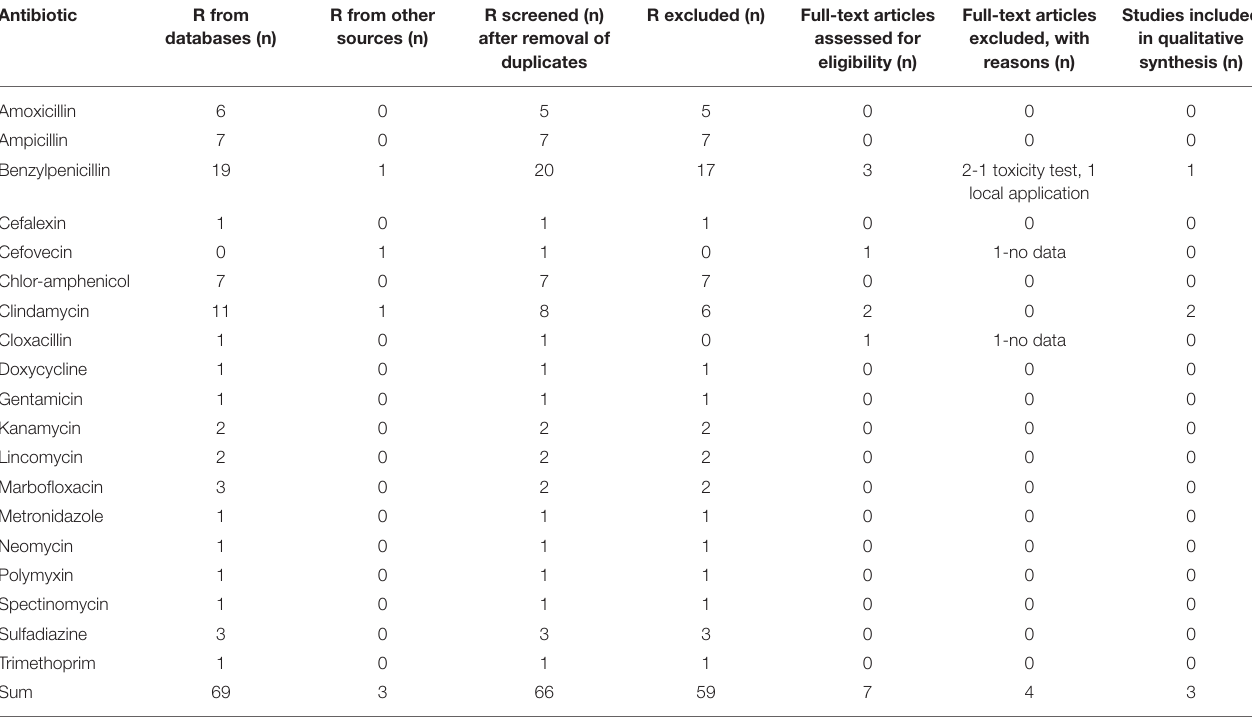
TABLE 3 | Literature search: number (n) of records (R) identified for approved antibiotics in cats. Antibiotic R from